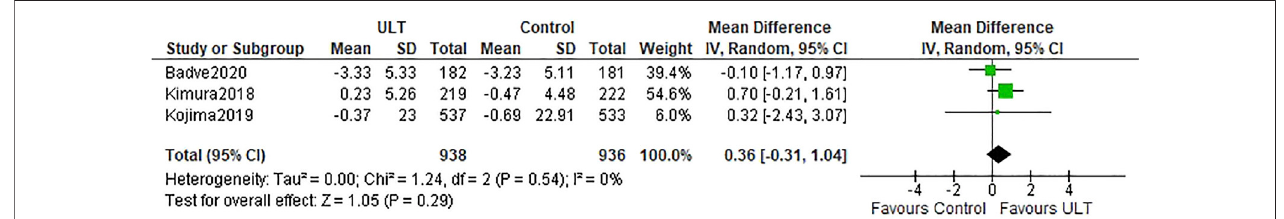
FIGURE 2 | eGFR slopes: ULT vs control group.